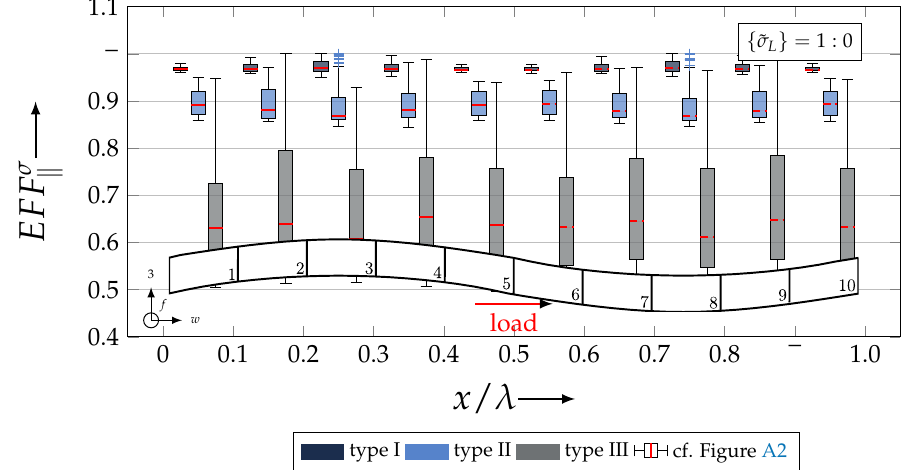
Figure 29. Illustration of stress effort EFF σ load ratio { ˜ σ L } = 1:0 for weft yarn ( EFF σ